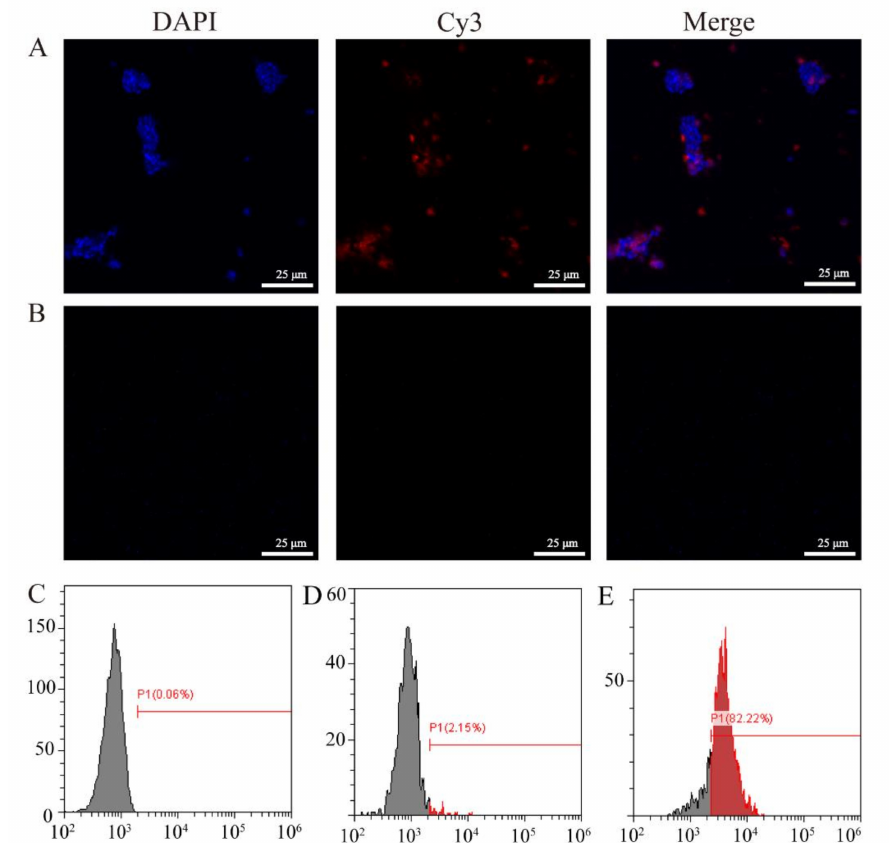
Figure 3. The expression of VP56-2 protein on the surface of spores was verified by immunofluo- rescence and flow cytometry. ( A , B ): The expression of CotC-VP56-2 spores by the immunofluores- cence method. CotC-VP56-2 spores were incubated with mouse anti-VP56 serum ( A ), CotC-VP4 spores were incubated with pure mouse serum ( B ) and then with Cy3-labeled goat anti-mouse IgG. The spores of CotC-VP56-2 are stained red, and the nucleus is stained blue. Scale bar: 25 µ m. ( D , E ): Flow cytometry to detect the positive expression rate of VP56-2 on the surface of recombi- nant spores. CotC-VP56-2 spores were incubated with pure mouse serum ( C ), CotC spores and CotC-VP56-2 spores were incubated with mouse anti-VP56 serum ( D , E ) and then incubated with FITC-conjugated goat anti-mouse